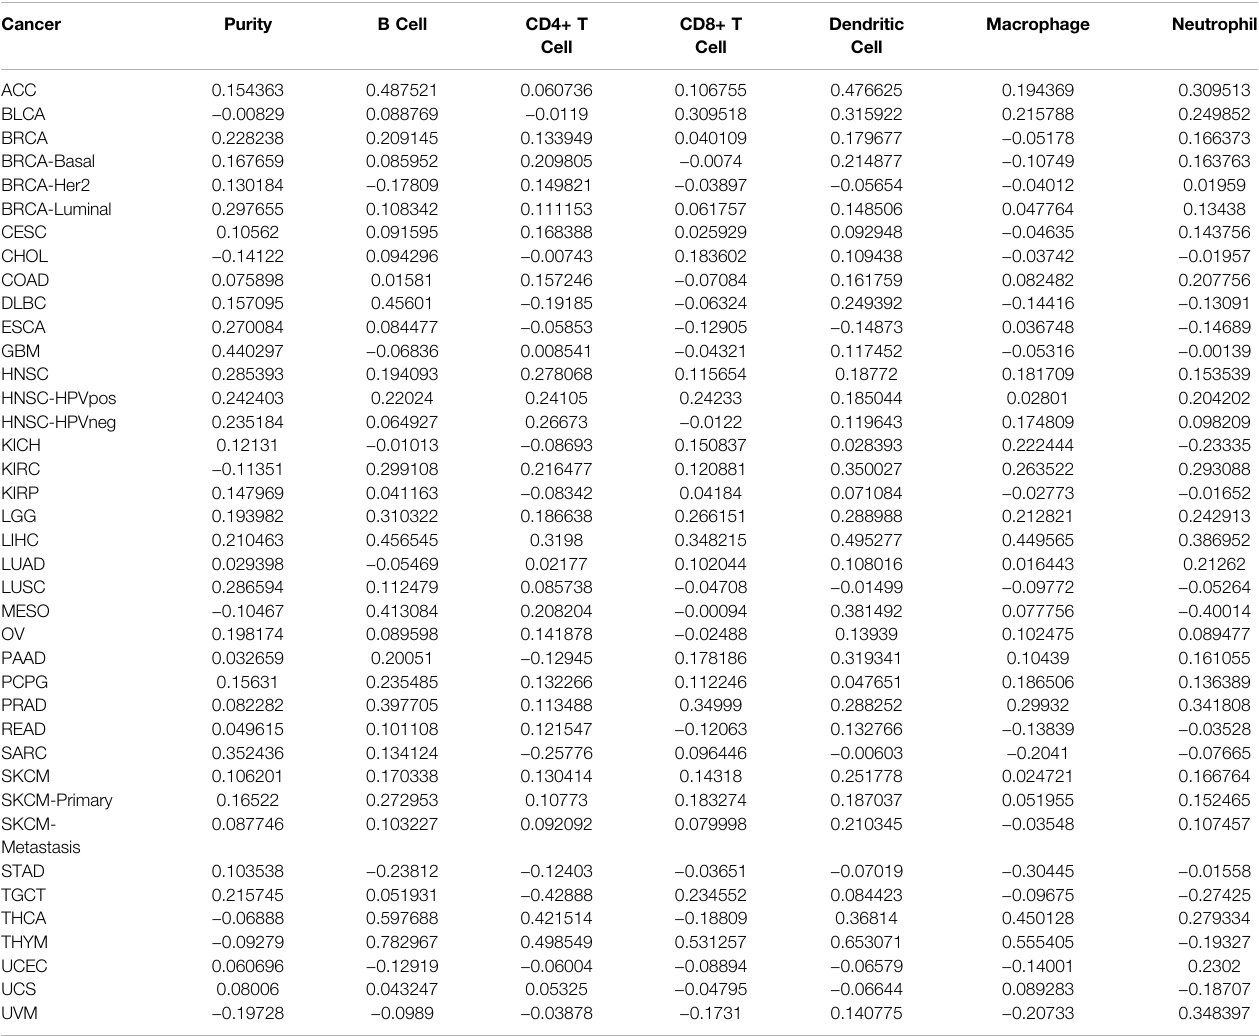
TABLE 1 | Correlation between cancers and immune cells.